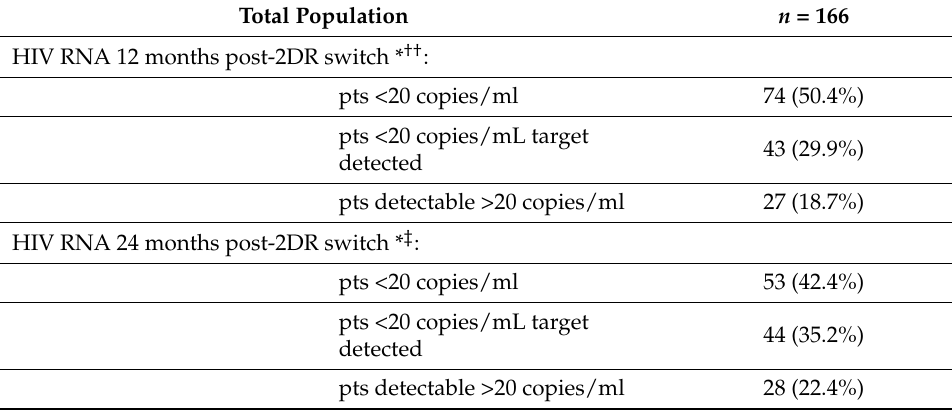
Table 1. Cont. Total Population n = 166 HIV RNA 12 months post-2DR switch * ††